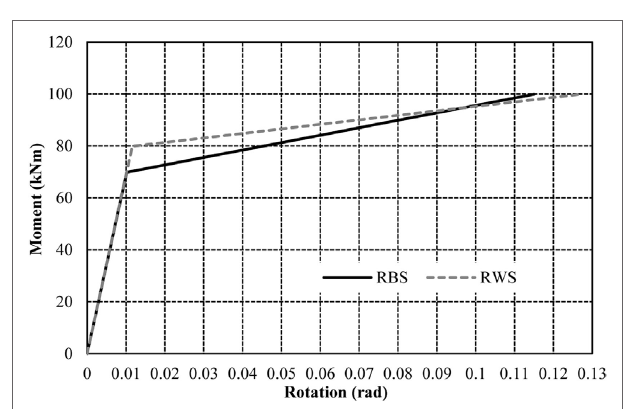
Figure 15 | Comparison of bilinear moment–rotation curves for reduced web section (RWS) and reduced beam section (RBS) with equivalent volume reduction from FEA analysis.